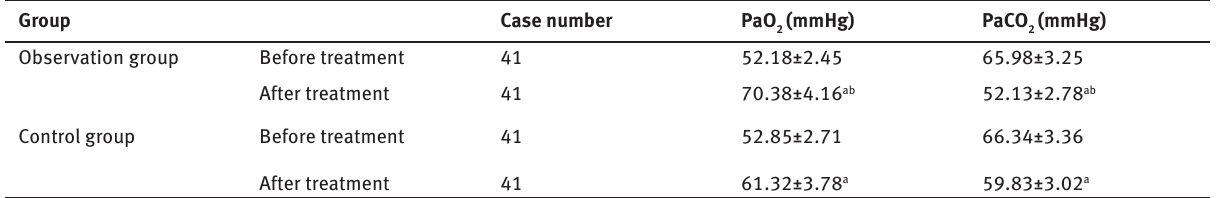
(mmHg) PaCO (mmHg) 2 2